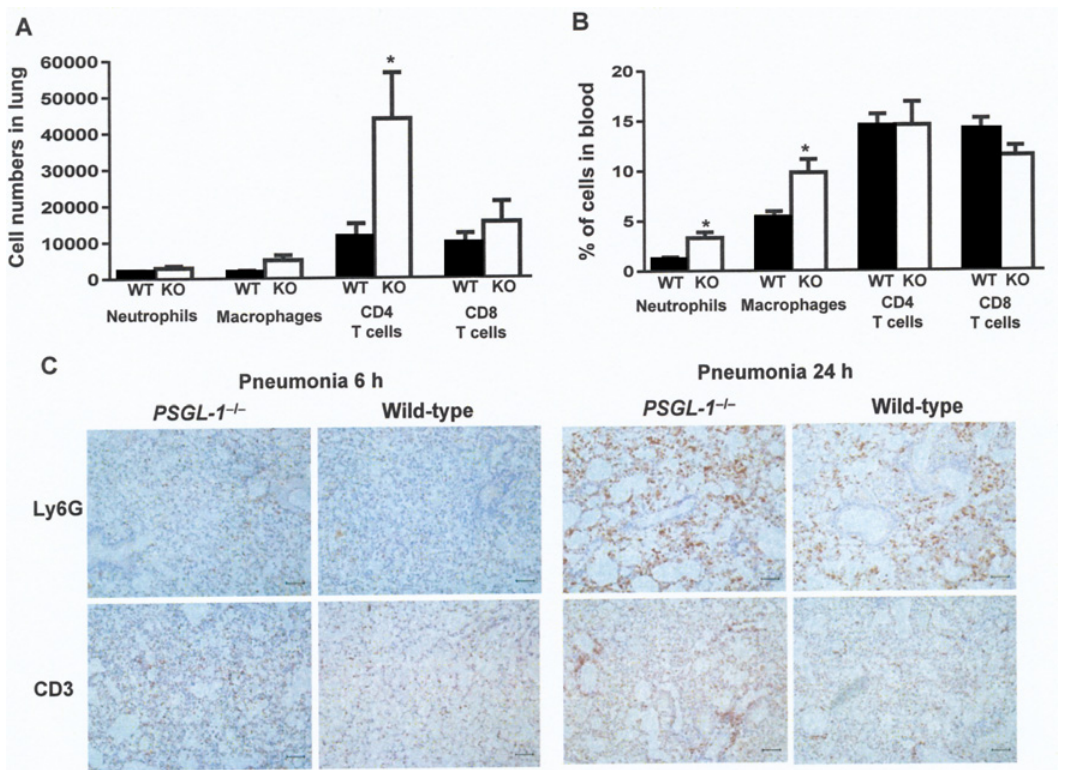
Fig 7. Contribution of PSGL-1 to cellular migration in lungs and blood of infected mice with S . pneumoniae . (A) Neutrophils, macrophages, CD4 + T and CD8 + T cells in the lungs of wild-type (black bars) or PSGL-1 − / − mice (open bars) after pneumonia infection. (B) Proportion of neutrophils, macrophages, CD4 + T and CD8 + T cells in the blood of wild-type (black bars) or PSGL-1 − / − mice (open bars) after intravenous infection. (C) Representative lung histological sections from infected mice that show granulocytes infiltrates in PSGL-1 − / − mice visualized by Ly6G staining. T cell infiltrates were observed by CD3 staining. Original magnification × 10. Scale bars represent 200 μ m.